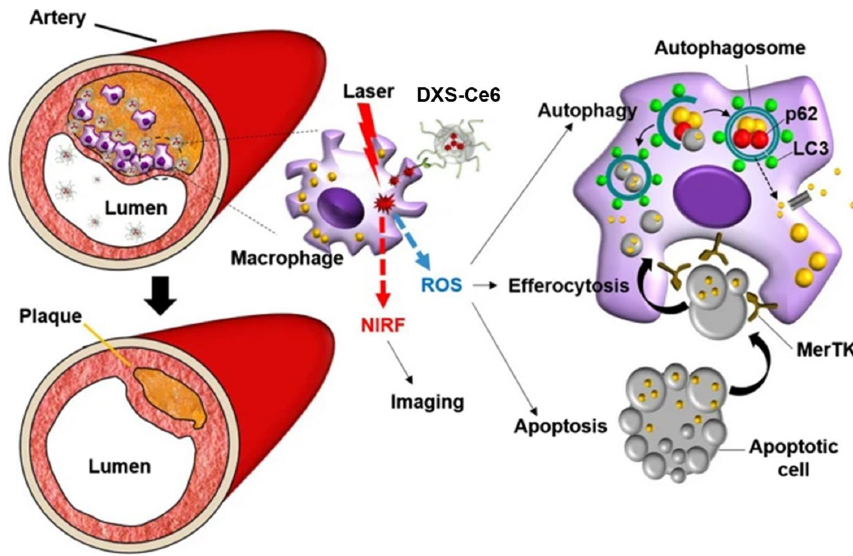
Figure 7. Schematic illustration of the macrophage SR-A targeted NIR fluorescence imaging and photoactivation of DXS-Ce6 for autophagy induction and efferocytosis enhancement to regress atherosclerosis. Adapted with permission from ref [75] . Copyright 2021 The authors.